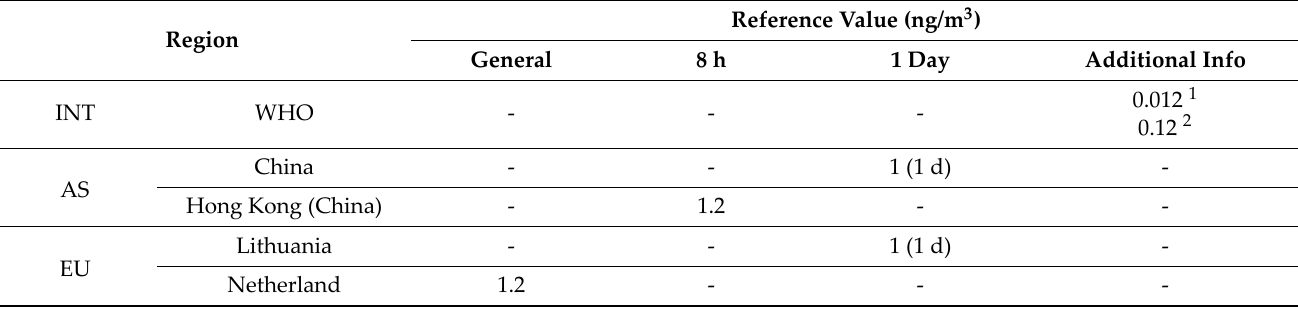
Table 5. Reference values for